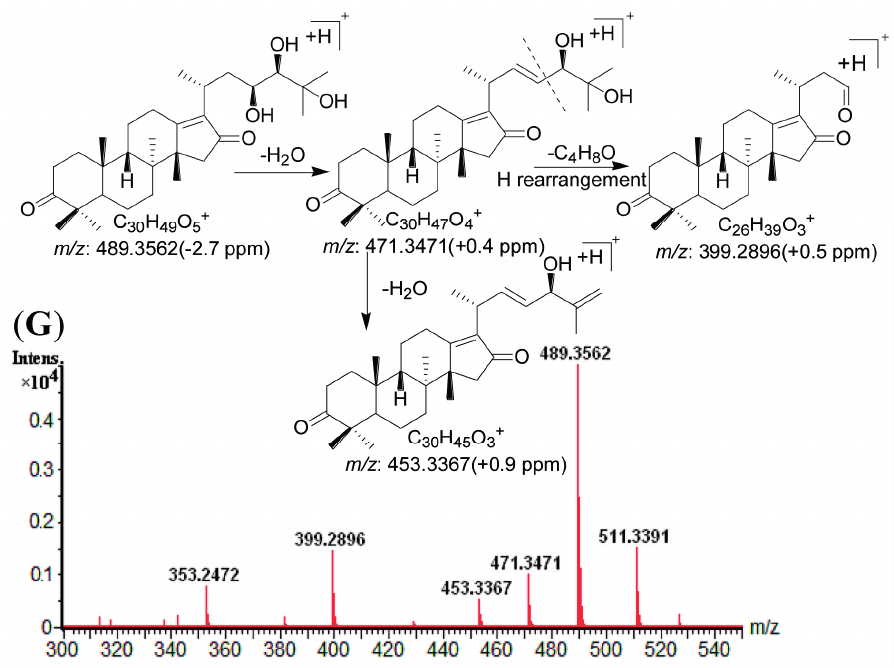
Figure 4. ( A ) The ESI-Q-TOF MS spectra and the proposed fragmentation pathway of alisol L; ( B ) The ESI-Q-TOF MS spectra and the proposed fragmentation pathway of alisol C-23acetate. (C) The ESI-Q-TOF MS spectra and the proposed fragmentation pathway of alisol B-23acetate; ( D ) The ESI-Q-TOF MS spectra and the proposed fragmentation pathway of alisol F-24acetate; ( E ) The ESI-Q-TOF MS spectra and the proposed fragmentation pathway of 11-deoxy-alisol B; ( F ) The ESI-Q-TOF MS spectra and the proposed fragmentation pathway of13,17-epoxy-alisol A; ( G ) The ESI-Q-TOF MS spectra and the proposed fragmentation pathway of 16-oxo-11-deoxy-alisol